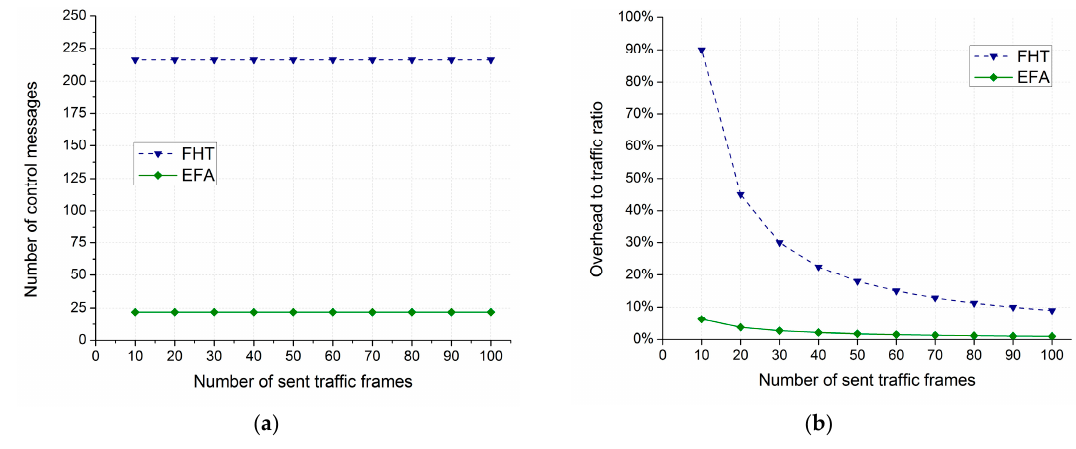
Figure 14. A comparison of overhead performance between the EFA and FHT. ( a ) Number of control messages; and ( b ) control messages to traffic frames ratio.